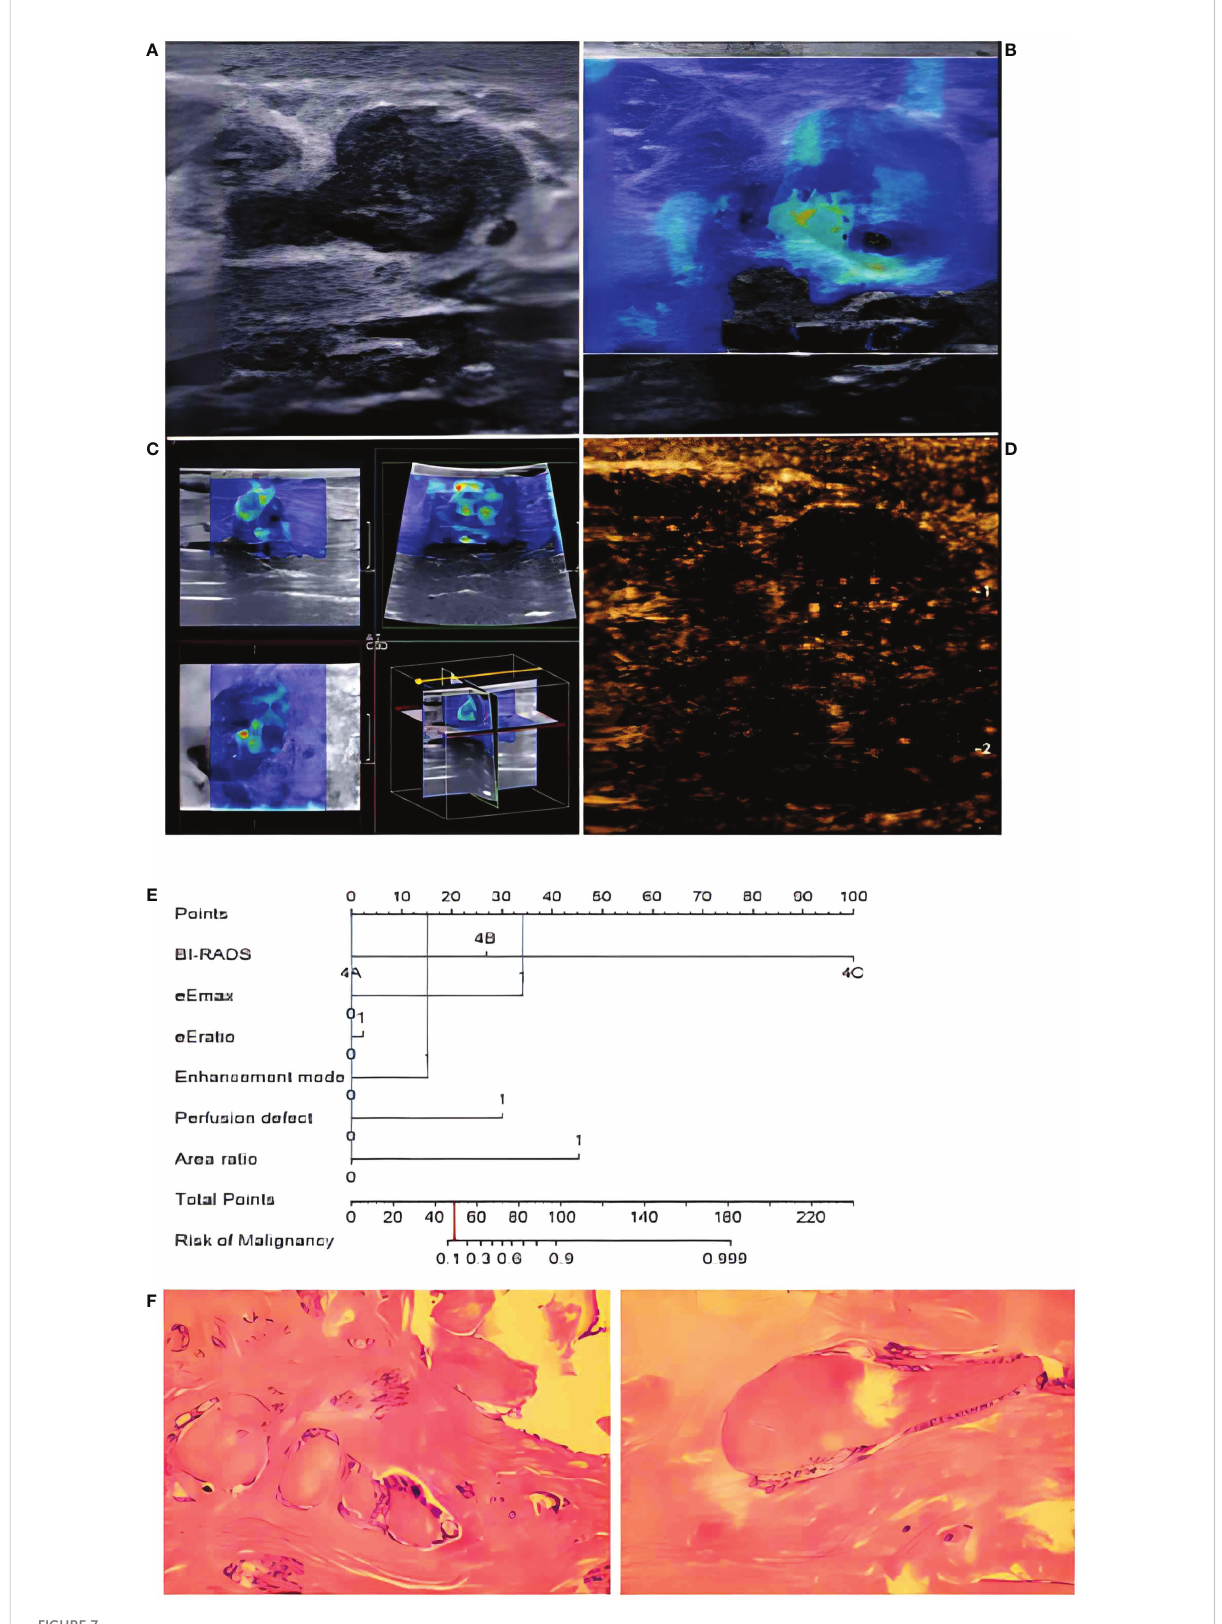
FIGURE 7 In a 48-year-old woman, B-mode imaging (A) showed a 2.0 × 1.1-cm hypoechoic lesion below the nipple, considered to be BI-RADS category 4A. In 2D-SWE (B) and 3D-SWE (C) , the lesion showed a polychrome or partly hard ring sign, indicating malignancy. In CEUS (D) , the lesion showed inhomogeneous low – no enhancement and a well-de fi ned margin, indicating a benign lesion. The risk degree of the nomogram (E) was less than 0.2, indicating a benign neoplasm. Pathology (F) showed that the lesion was a fi